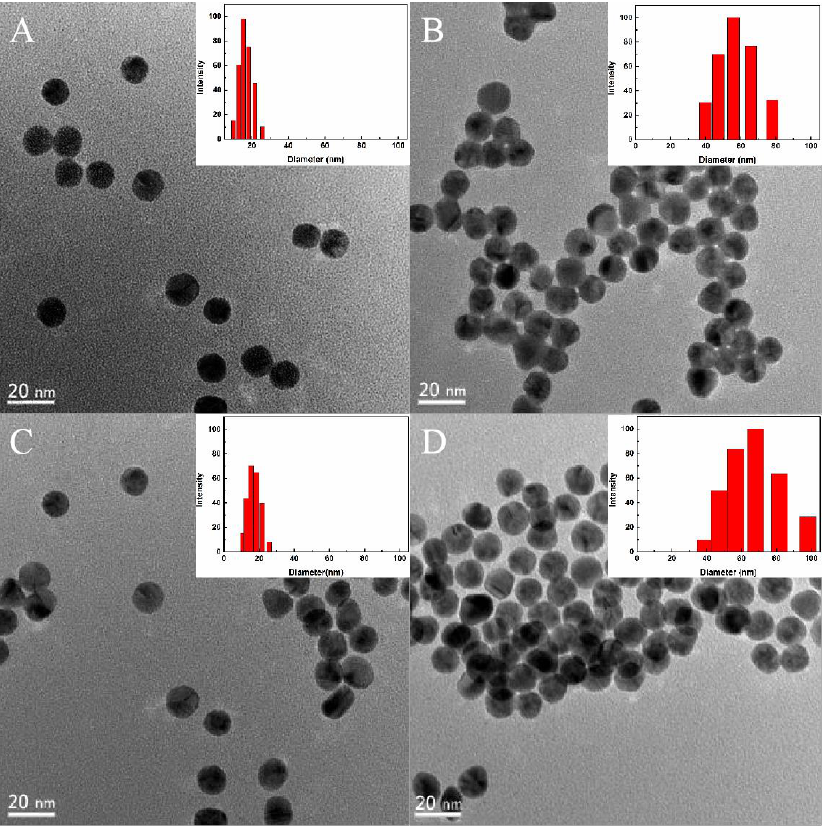
Figure 2. TEM images and particle size distribution of AuNPs added to different materials. ( A ) AuNPs, ( B ) added PDDA, ( C ) added aptamer, and ( D ) added Cd(II).